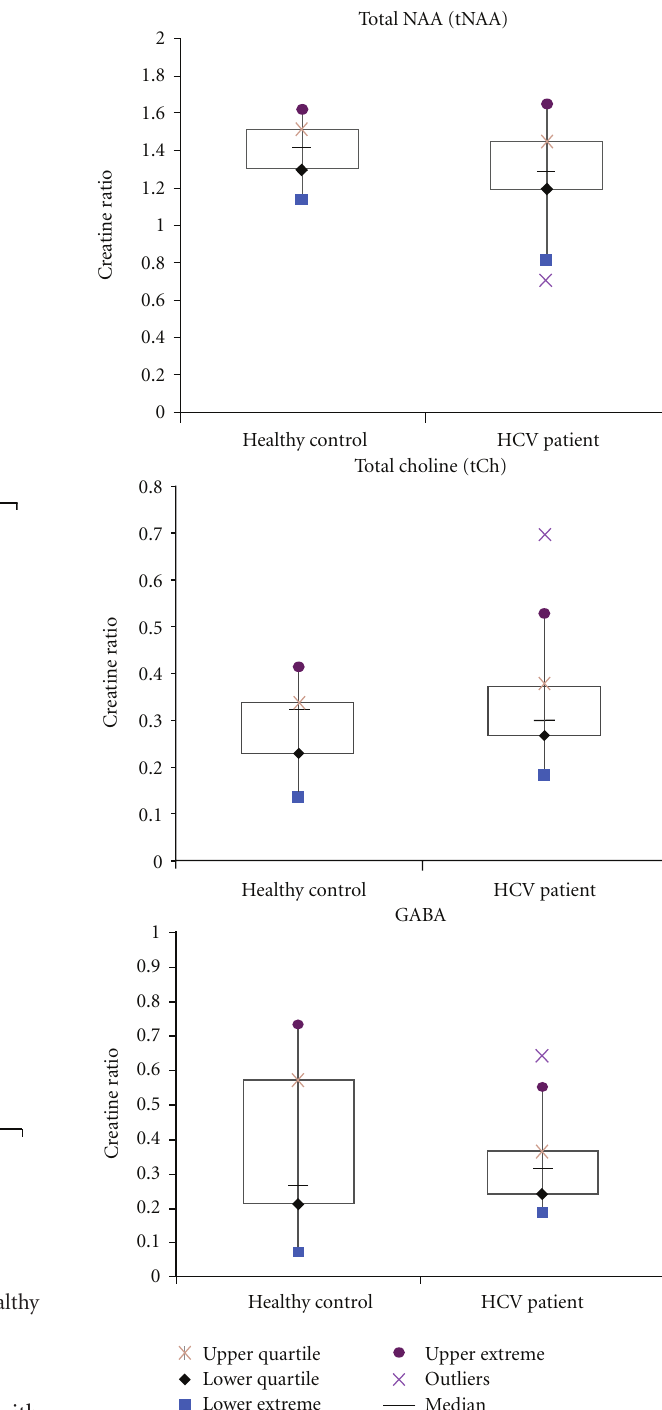
Figure 5: Box and Whisker plots of selected metabolites changes between healthy controls and HCV+